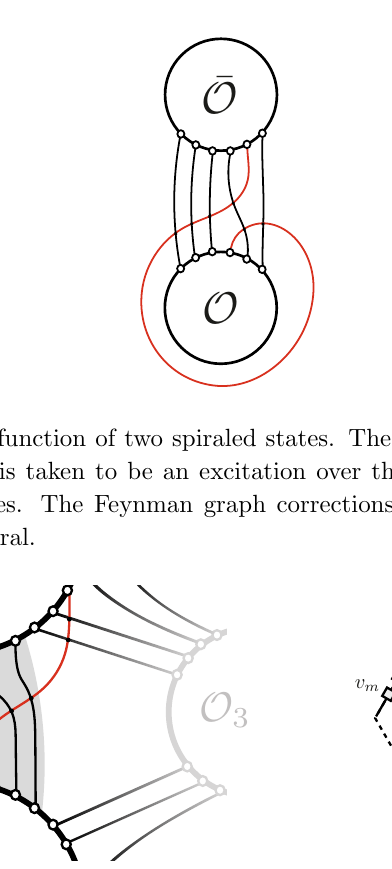
so that the only nontrivial O 3